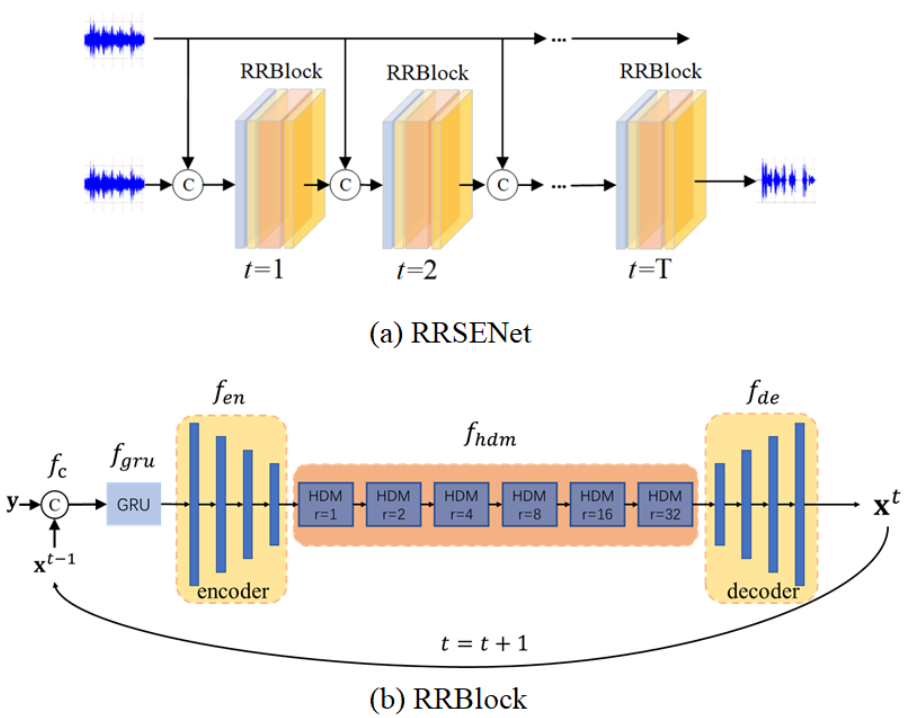
Figure 4. ( a ) RRSENet: recursive recurrent speech enhancement network, ( b ) RRBlock: recursive recurrent